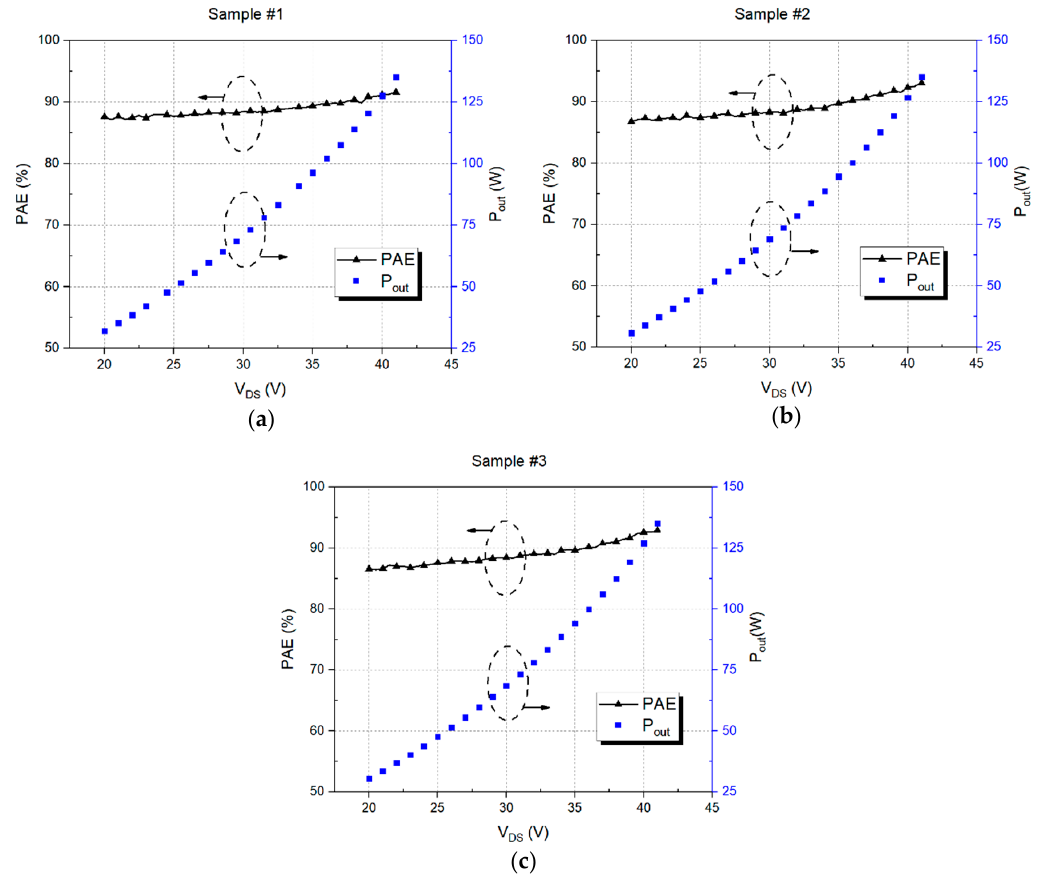
Figure 12. Measurements of the output power and PAE of the proposed power module: ( a ) Sample #1; ( b ) sample #2; and ( c ) sample #3.